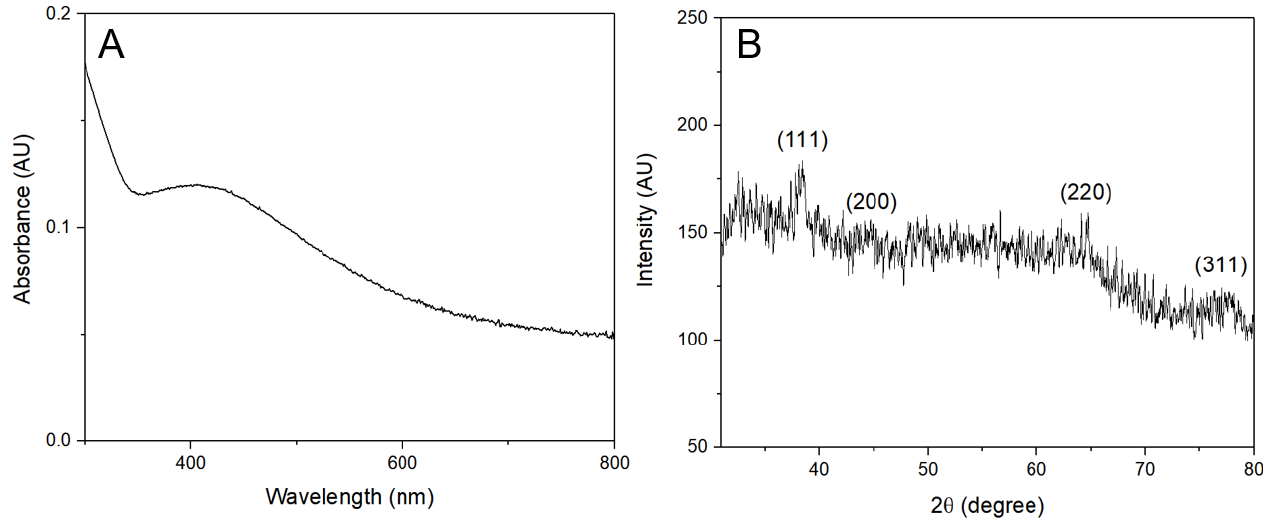
Figure 2. Characterization of the AgNPs synthesized with lemon peel extract. ( A ) UV-vis absorbance spectrum ofthe AgNPs. ( B ) XRD pattern of the AgNPs with labeled diffraction peaks.